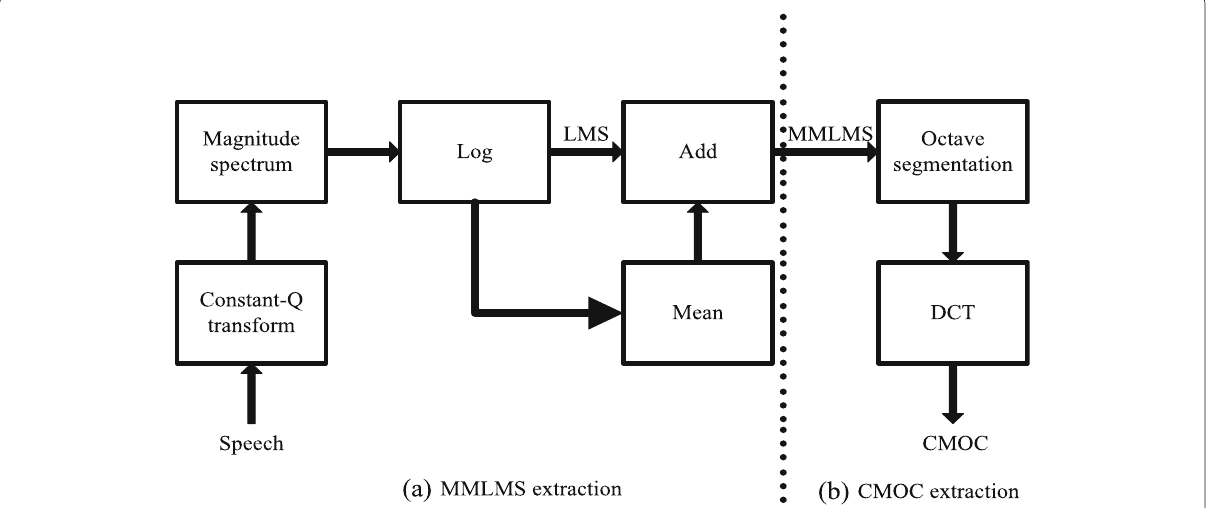
Fig. 2 Schematic diagram of constant-Q mean-based octave coefficients extraction, including a MMLMS extraction and b CMOC